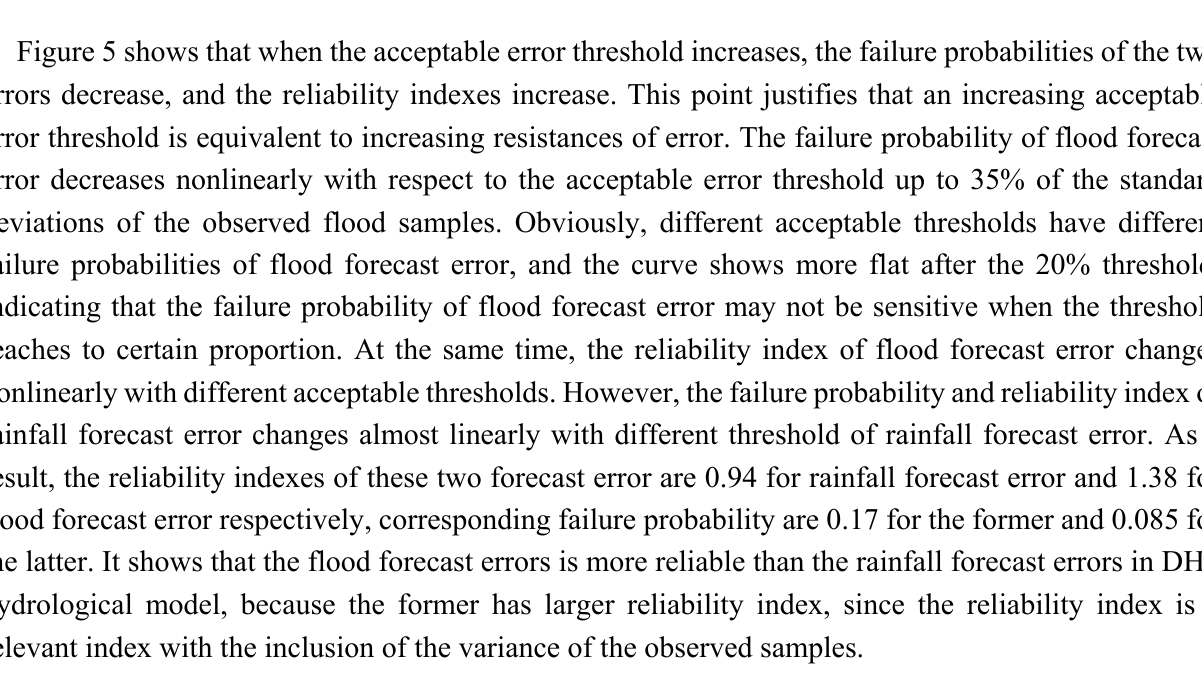
Figure 5. Failure probabilities and reliability indexes of rainfall forecast errors and flood forecast errors for DHF